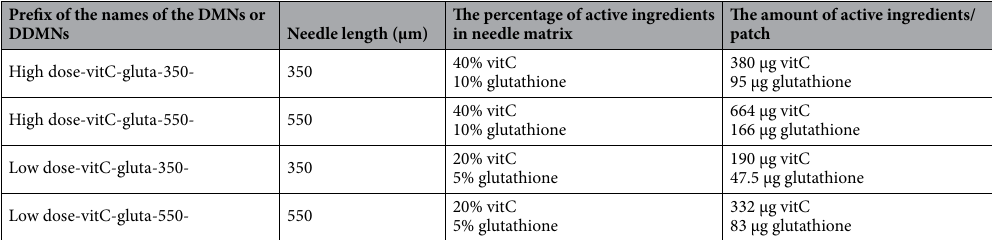
The percentage of active ingredients in needle matrix